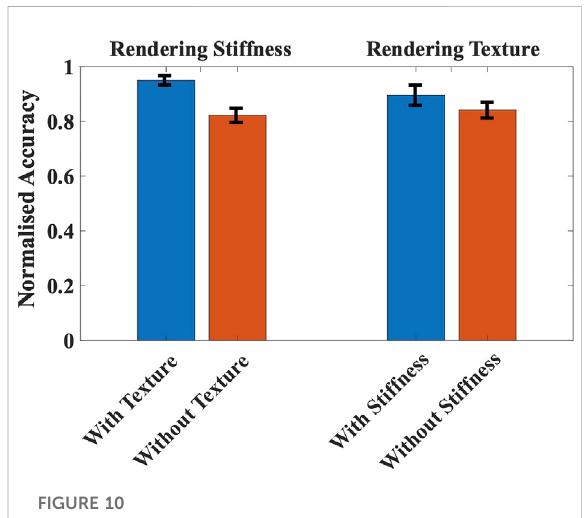
FIGURE 10 Comparison of normalized mean accuracy of rendering stiffness with/without textures and rendering texture with/without stiffness. The error bars indicate the standard deviation of the normalized accuracy.